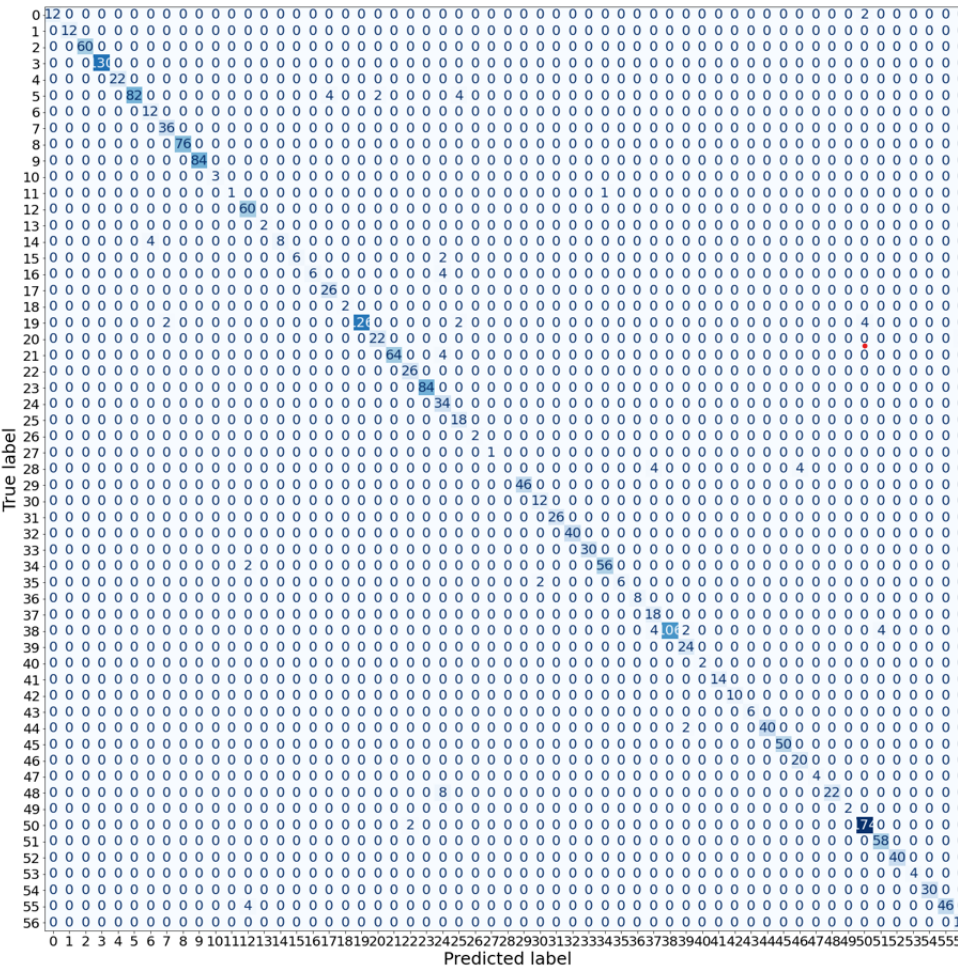
Figure 11. Confusion matrix of ensemble learning on the TSRD dataset.